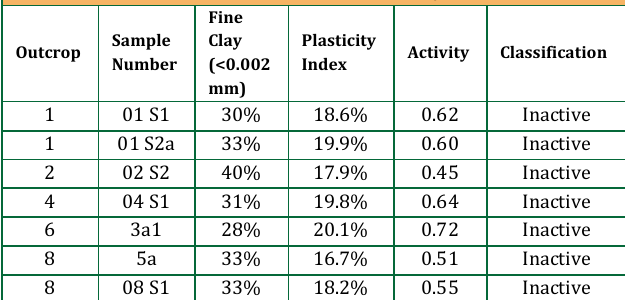
Table 7: Activity classification of mudstones (Class limits after